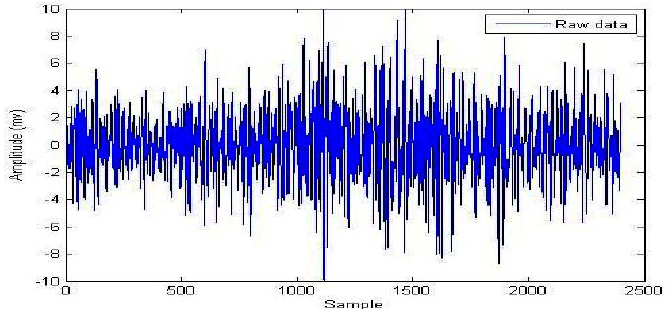
Figure 4. Raw EMG data from right vastus medialis muscle during maximum walking